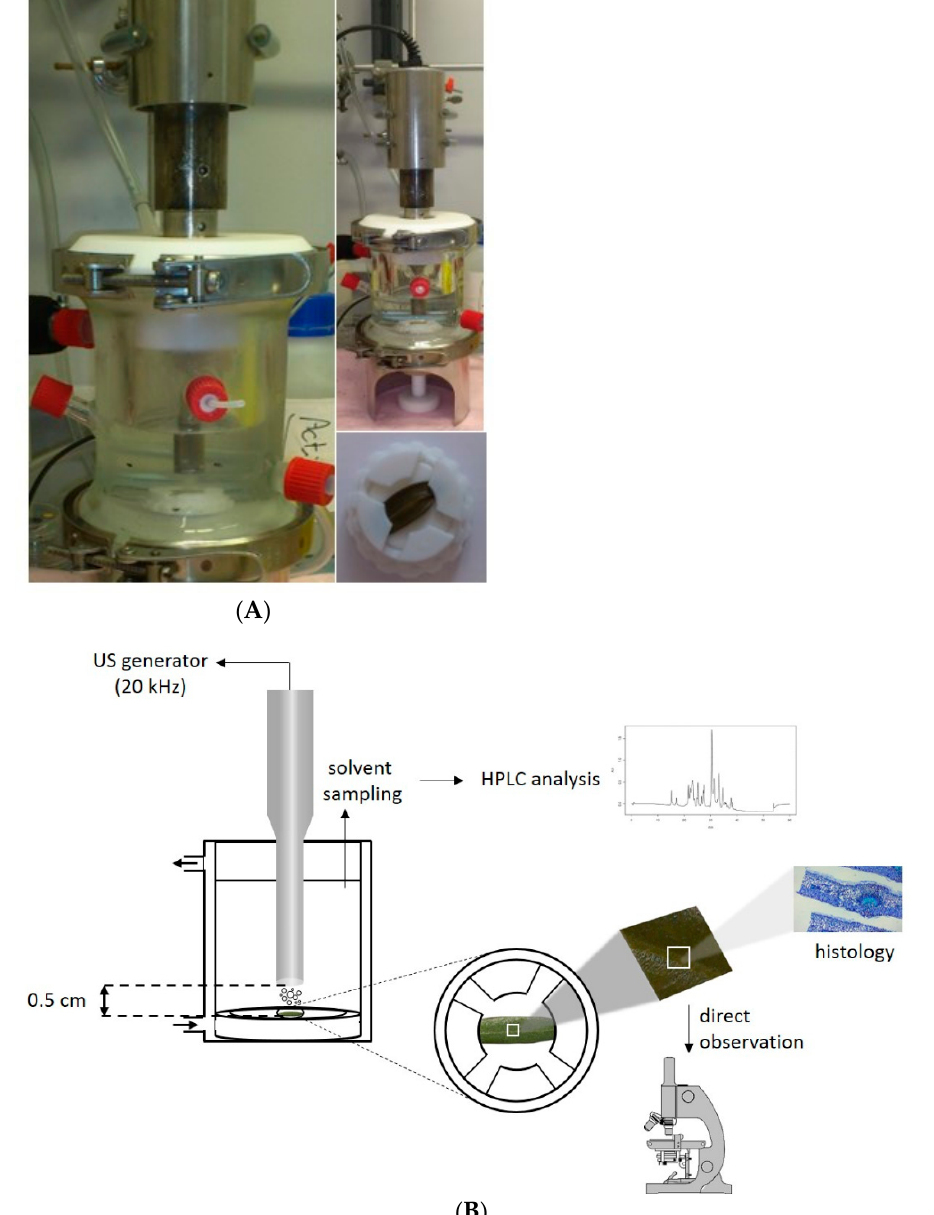
Figure 1. Abstract figure (( A ), picture of the experimental setup, and sample holder, ( B ), experimental methodology).